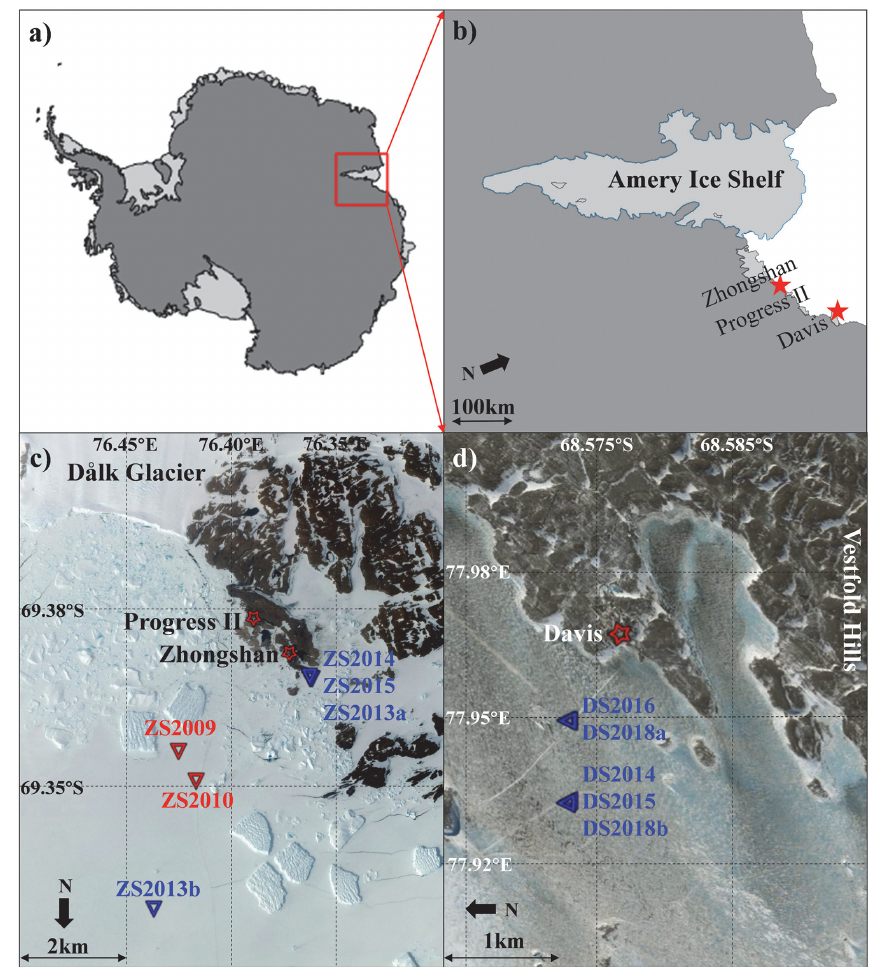
Figure 1. Study area. (a) Antarctica with the red square indicating the study region. (b) The study region with the red stars indicating the Chinese Zhongshan Station (ZS), the Russian Progress II Station, and the Australian Davis Station (DS). (c) Close-up of ZS with the background showing a Landsat optical image obtained on 4 January 2011. (d) Close-up of DS with the background showing a Landsat optical image obtained on 13 October 2012. The red and blue triangles in panels (c) and (d) denote the CRREL-IMB and SIMBA deployment sites,